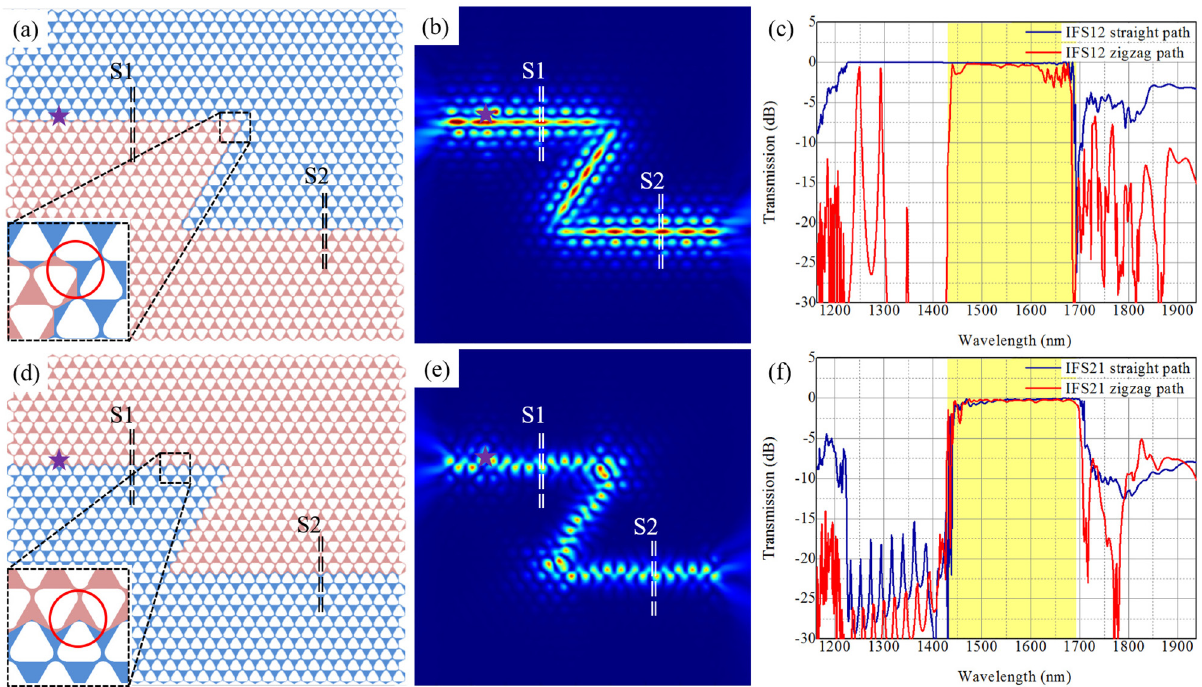
Figure4: (a)SchematicoftheIFS12zigzagpathformedbyVPC1(blue)andVPC2(red)with a =407nm, η (cid:1) 0 . 99,and ρ (cid:1) 0 . 35.(b)Electric fi eld distribution of the edge state traveling at 1550 nm along the IFS12 zigzag path. (c) Transmission spectra of the edge state of the IFS12 zigzag path and the IFS12 straight path. The yellow shaded indicate the bandwidth calculated by the energy spectrum shown in Figure 3b. (d) Schematicof the IFS21zigzag path with a = 407 nm, η (cid:1) 0 . 99, and ρ (cid:1) 0 . 35. (e)Electric fi elddistributionof the edgestatetravelingat 1550 nm along the IFS21 zigzag path. (f) Transmission spectra of the edge state of the IFS21 zigzag path and the IFS21 straight path. The red circles in (a) and (d) highlight the same structure between the sharp corner part of the IFS12 zigzag path and the IFS21 straight path. The purple star indicates the dipole source. S1 and S2 are two power monitors used for calculating the transmission.